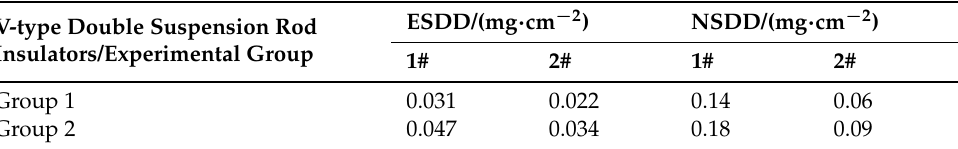
Table 1. ESDD and NSDD of two